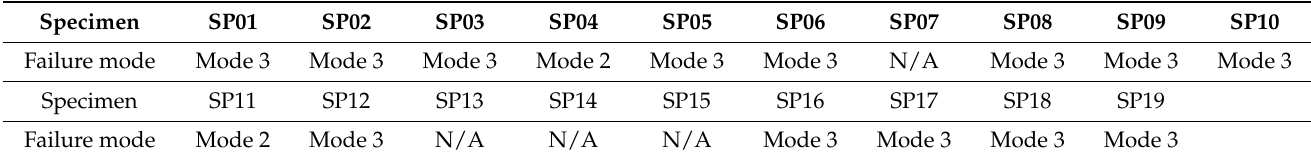
Table 7. Failure modes in developed models.